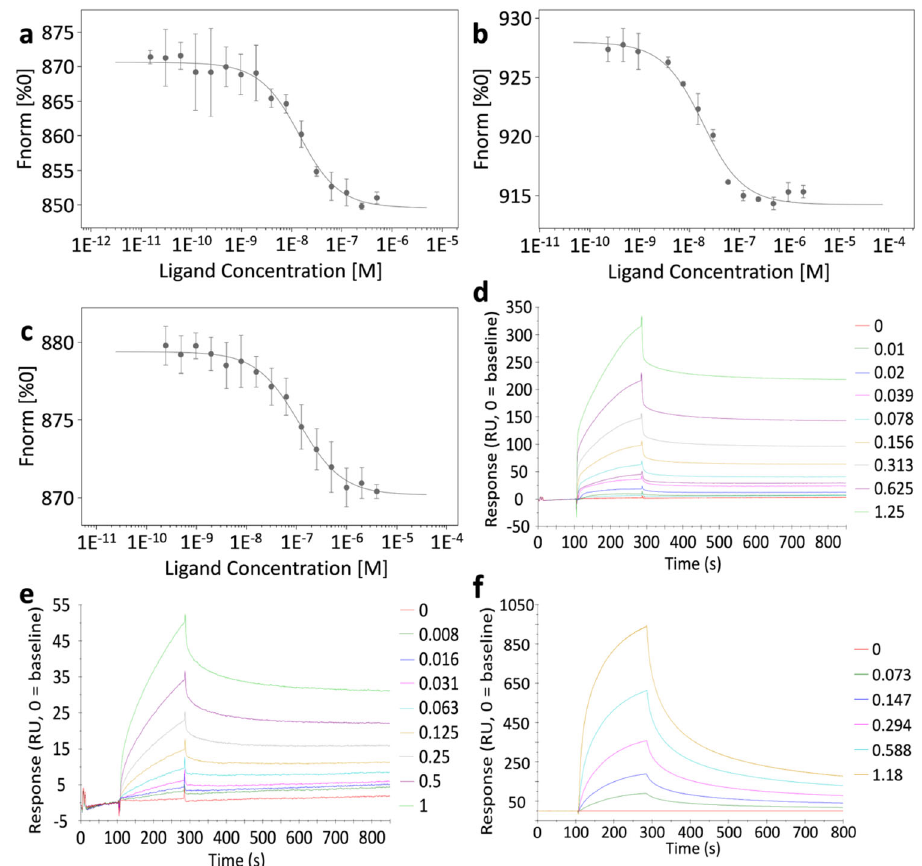
Fig. 6 The MST dose-response curves and SPR sensorgrams. The dose-response curve between a RlpA- Δ 32 and MltF2, b RlpA- Δ 32 and PBP1b, c RlpA- Δ 32·MltF2 and PBP1b. RlpA- Δ 32 at a concentration of 5 nM is set as the fl uorescently-labeled target throughout each MST run (ligand units are in molar). d RlpA- Δ 32 and MltF2 SPR sensorgram, with concentrations of the latter decreasing in two-fold dilution. e RlpA- Δ 32 and PBP1a SPR sensorgram, with concentrations of the latter decreasing at fi ve-fold dilutions. f RlpA- Δ 32·MltF2 and PBP1a SPR sensorgram, with concentrations of the latter decreasing at two-fold dilutions. RlpA- Δ 32 is set as the immobilized ligand on the surface of the carboxymethylated dextran chip throughout the SPR runs. The response is measured in response units (RU). Concentration units for SPR experiments are given in μ M. The baseline is corrected to zero. a – c Data were presented as means ± SD from triplicate experiments. View Supplementary Data for source